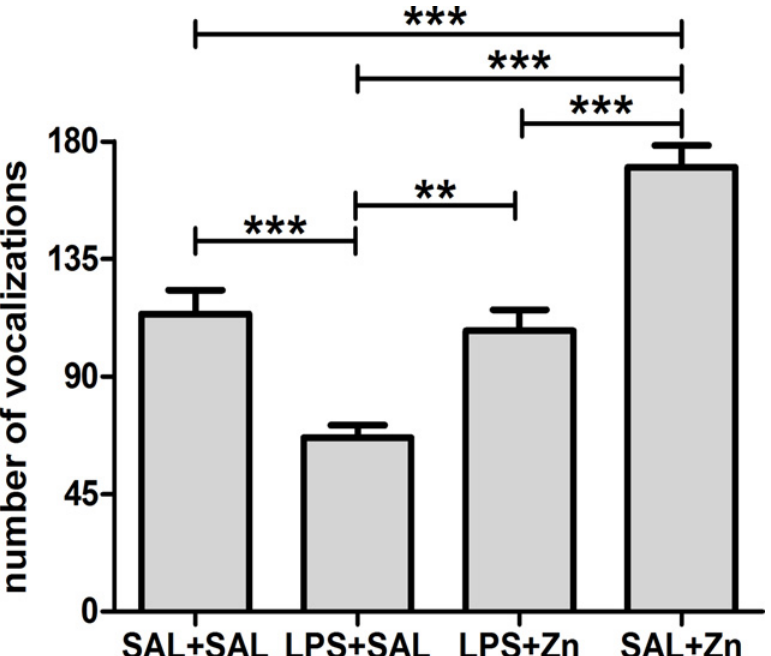
Fig 1. Number of vocalizations. Effects of LPS (100 μ g/kg) and zinc (ZnSO 4 ; 2 mg/kg) on the number of 22- kHz ultrasonic vocalizations in adult male rats after a restraint stress challenge. SAL+SAL, saline injection followed by another saline injection 1 h later; LPS+SAL, LPS injection followed by a saline injection 1 h later; LPS+Zn, LPS injection followed by a zinc injection 1 h later; SAL+Zn, saline injection followed by a zinc injection 1 h later ( n = 10 per group). ** p < 0.01, *** p < 0.0001 (one-way ANOVA followed by the Tukey test). The data are expressed as the mean ±